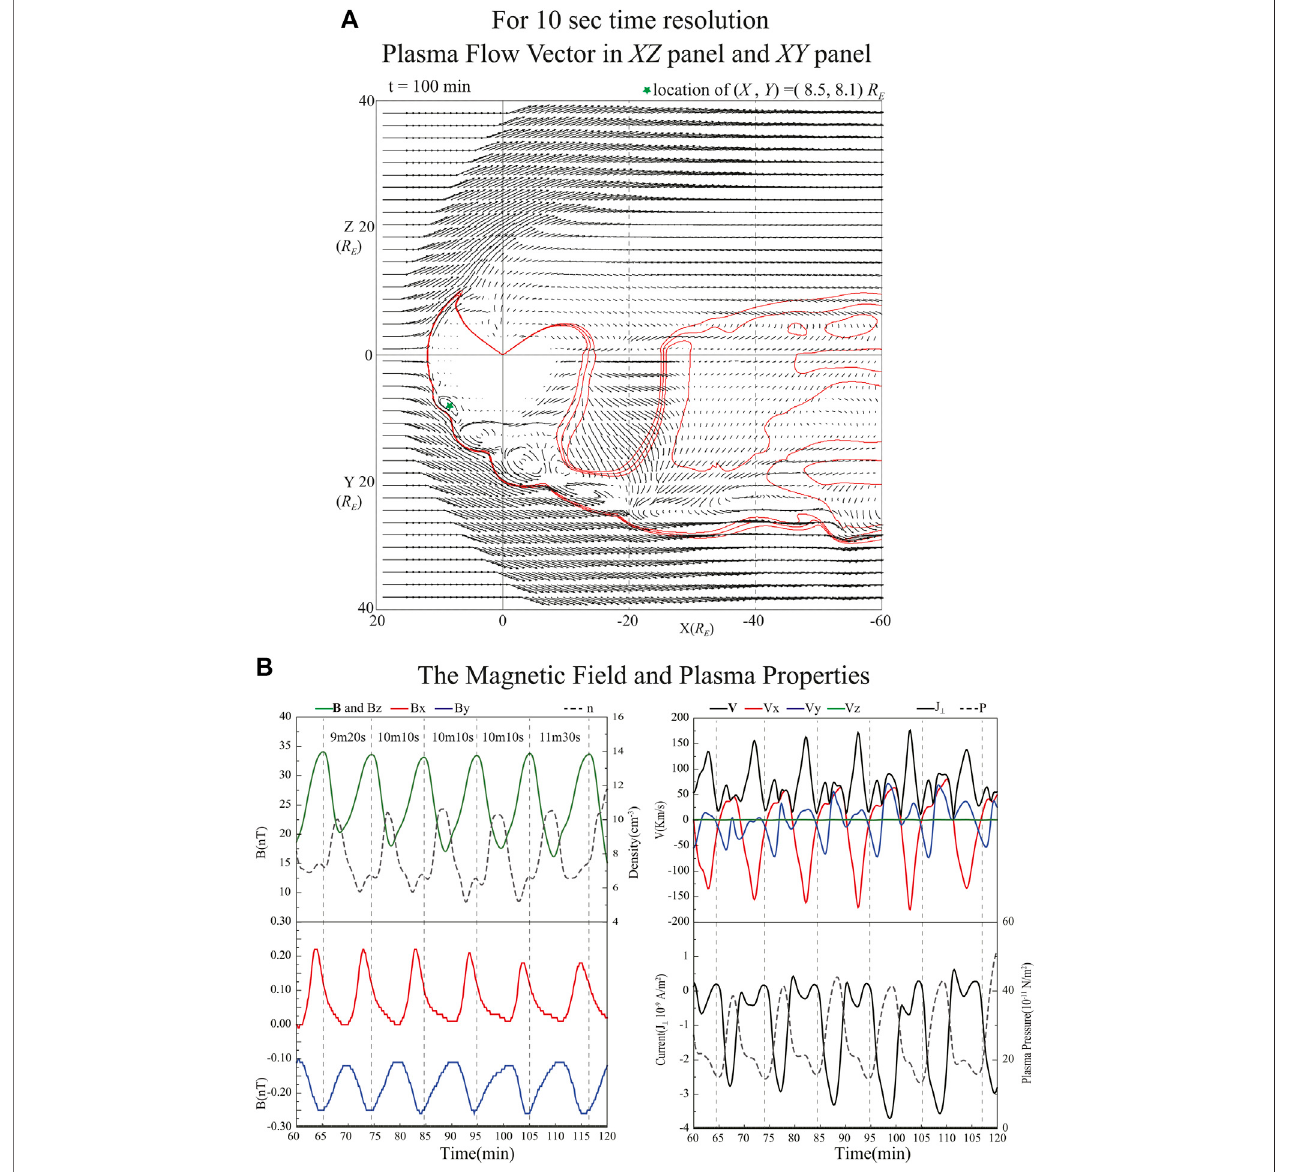
FIGURE 8 | The plasma fl ow vectors in the XZ (top) and XY planes (bottom) at time t (cid:1) 100 min in simulation of 10 s time resolution for the weak southward condition in (A) . The red lines are contours of the B z (cid:1) 0 region. (B) show the time evolution of the magnetic fi eld and plasm properties in the region of X (cid:1) 8.5 R E , Y (cid:1) 8.1 R E and Z (cid:1) 0 R E